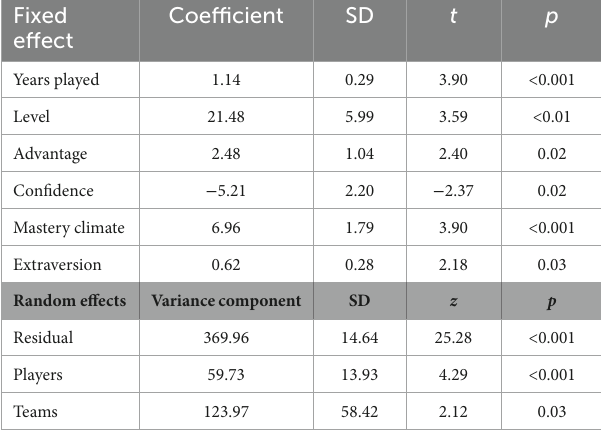
TABLE 3 Linear mixed model, full model for predicting football performance.